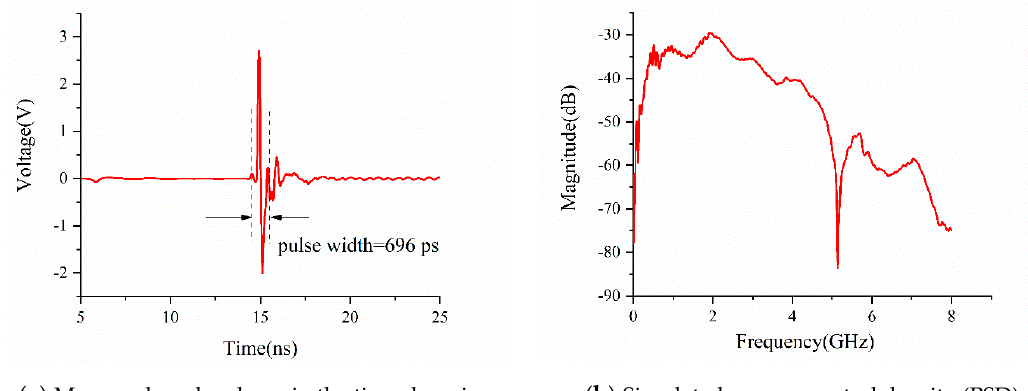
Figure 2. Measured performance of the monocycle pulse of the pulse generator (V2 in Figure 1).